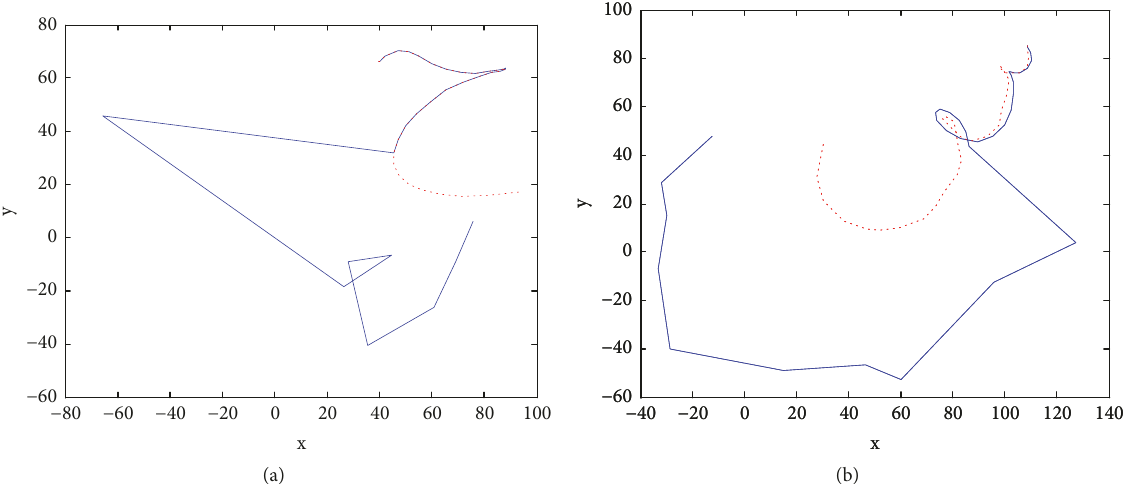
(cid:2) , « HA». (b) Arabic letter,